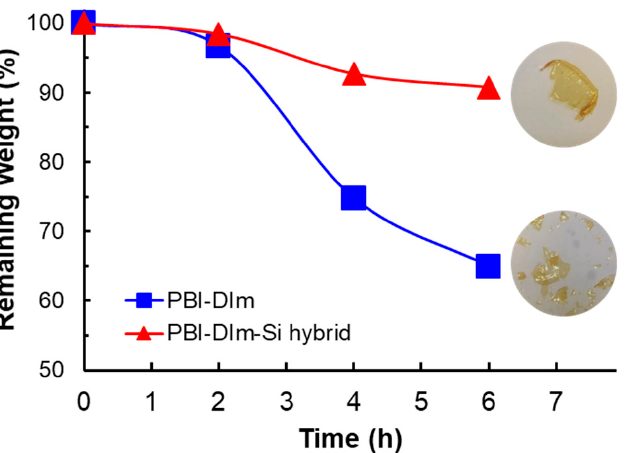
Figure 7. Oxidative stability of the PBI-DIm and PBI-DIm-Si hybrid membranes.